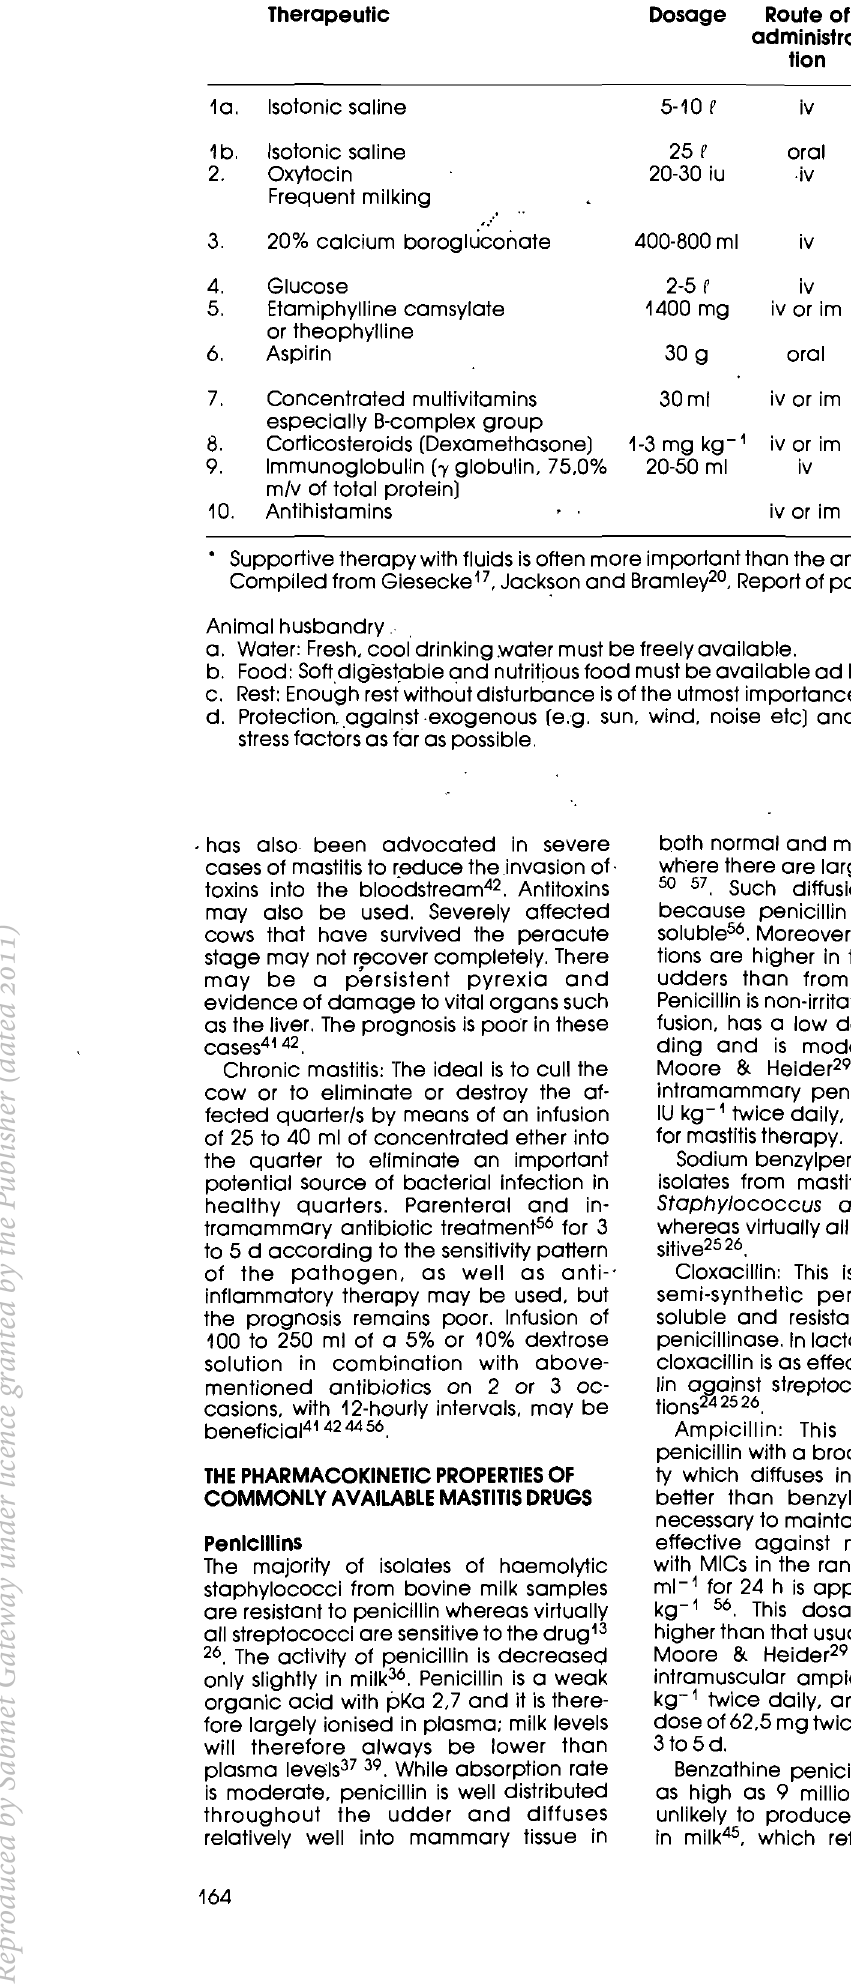
administra- between Comments